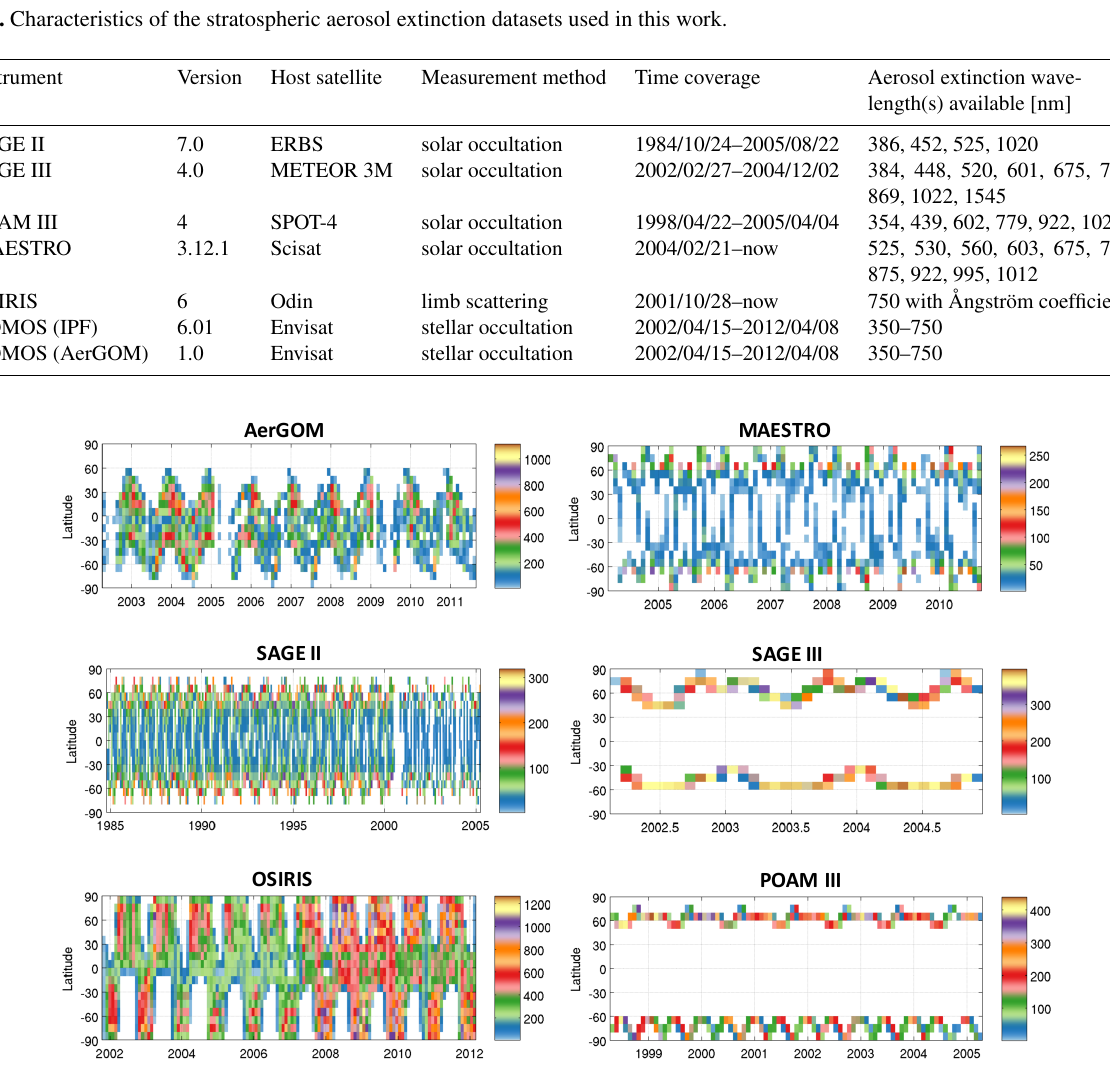
Figure 2. Latitude and temporal coverage for the various instruments used for the intercomparisons. The number of observations per month is calculated for a 10 ◦ latitude bin. The colour code gives the number of observations per